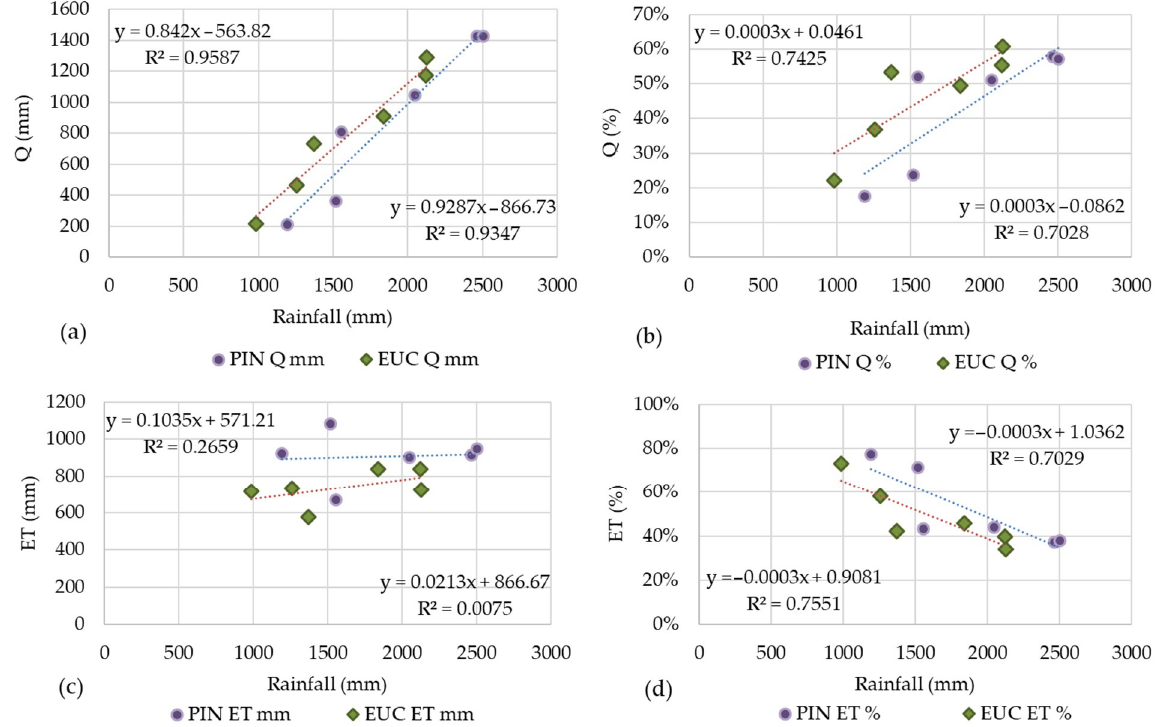
Figure 3. Linear relationship and equation in both Lourizela (PIN; right side) and Serra de Cima (EUC; left side) catchments over the 6 hydrological years investigated, recorded between annual rainfall and ( a ) annual streamflow (mm); ( b ) annual runoff coefficient (%); ( c ) annual evapotranspiration (mm); ( d ) annual evapotranspiration coefficient